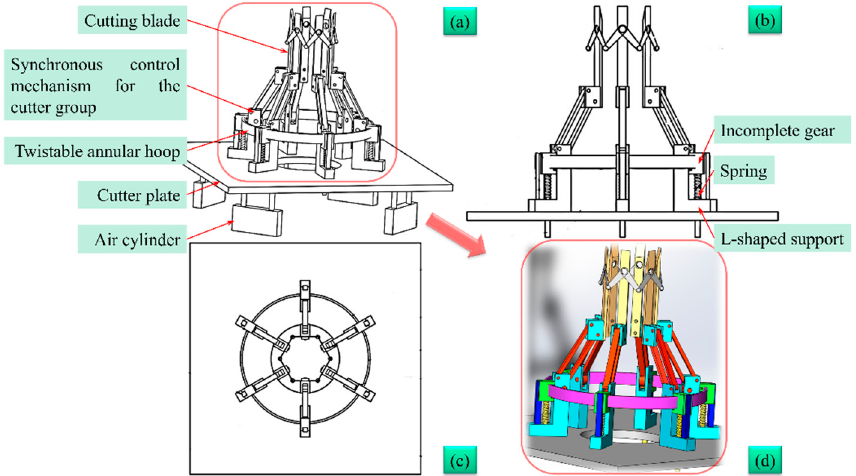
Figure 9. Plunge-cutting de-handing mechanism with variable diameter. ( a ) Side view, ( b ) Front Figure 9. Plunge ‐ cutting de ‐ handing mechanism with variable diameter. ( a ) Side view, ( b ) Front view, ( c ) Top view, ( d ) Side view of key view, ( c ) Top view, ( d ) Side view of key components.